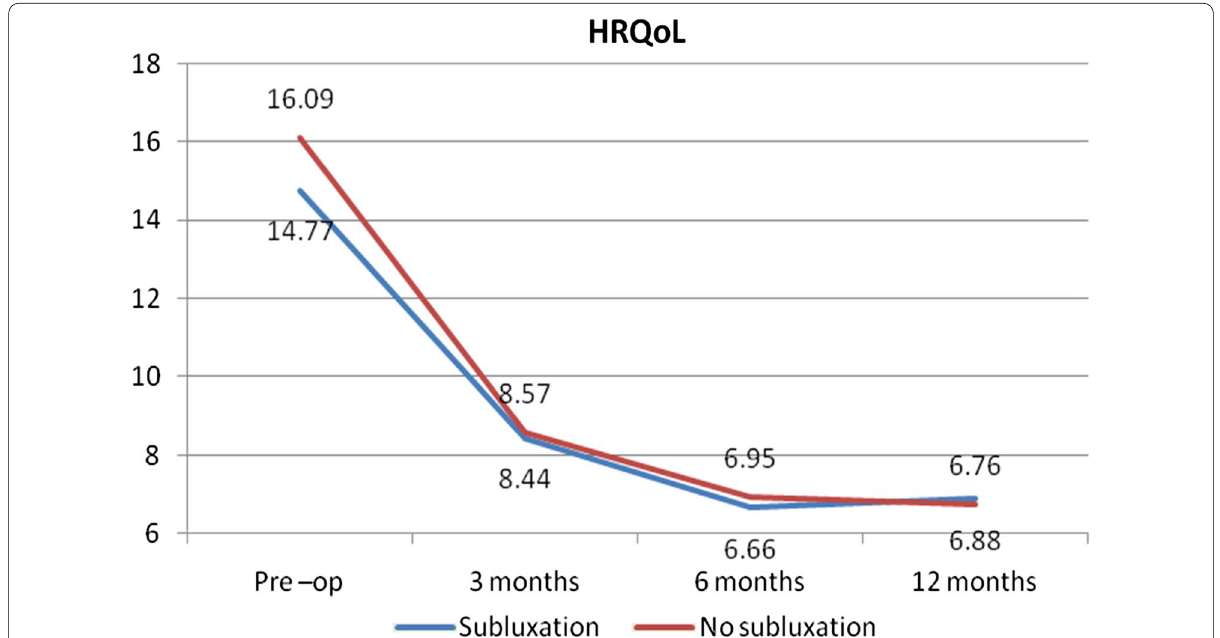
Fig. 5 Line diagram depicting the HRQoL in patients of multilevel lumbar canal stenosis with and without subluxation and showed the similar improvement in both the group in the postoperative